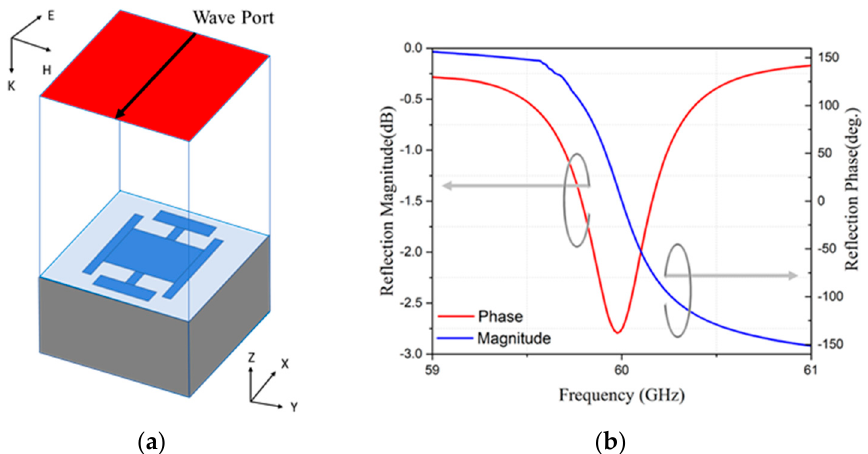
Figure 14. ( a ) Artificial magnetic conductor simulation model; ( b ) Reflection magnitude and phase for AMC.